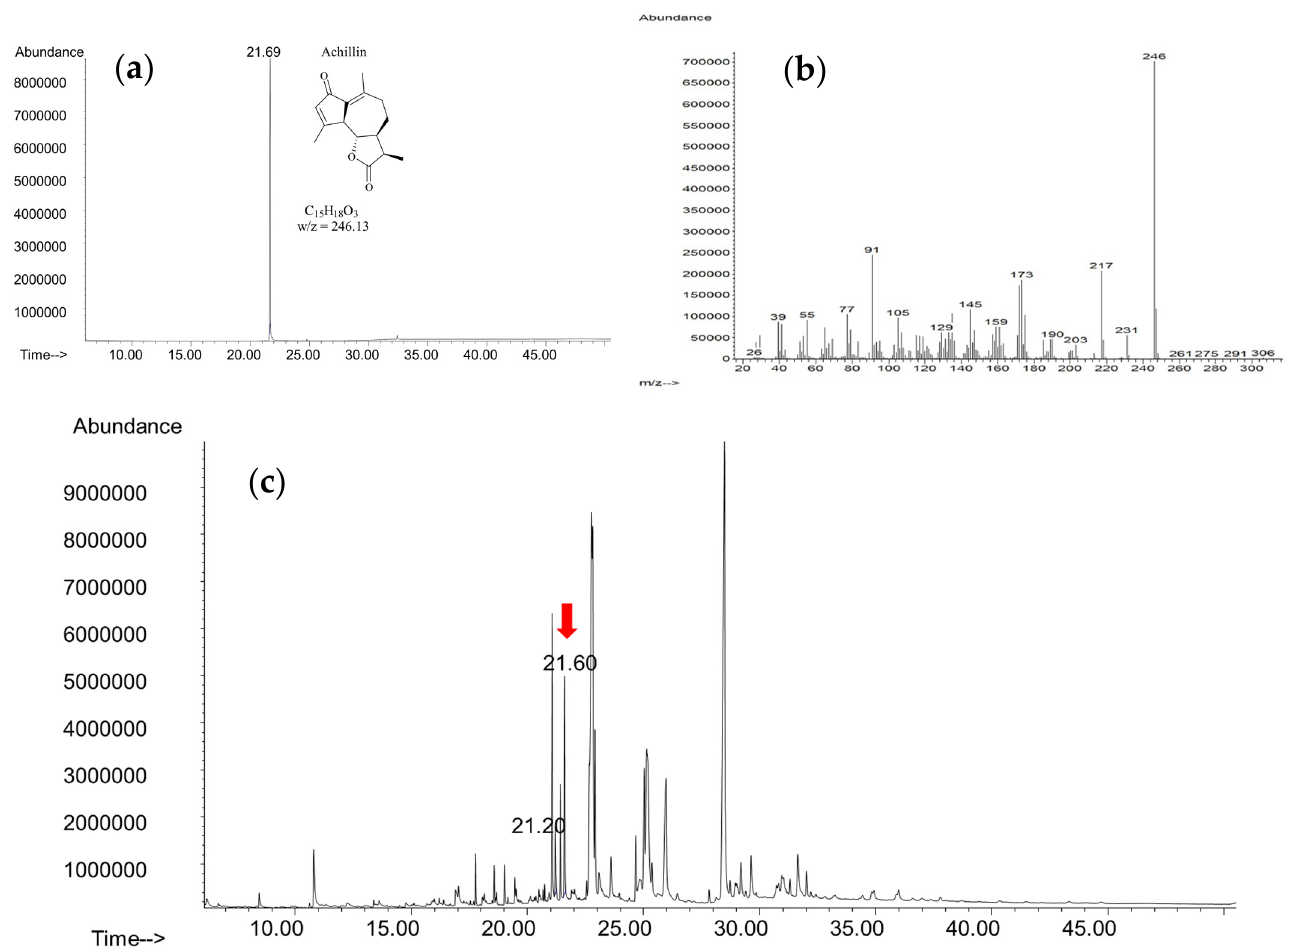
Figure 6. Achillin analysis by gas chromatography-mass spectrometry: ( a ) achillin isolated from A. ludoviciana wild plant; ( b ) achillin fragmentation pattern; ( c ) chromatogram of a callus extract from nodal explant with BAP (0.1 mg/L) plus NAA (1.0 mg/L), 1041.15 ± 16.47 µg/g dry biomass achillin compound. Table 4. Achillin content in the biomass of different morphogenetic responses (callus and plantlets) of A. ludoviciana analyzed by GC-MS.